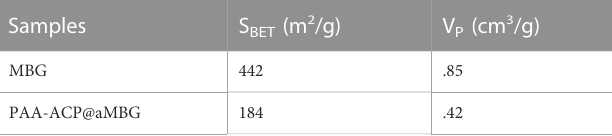
TABLE 1 Speci fi c surface areas and pore volumes of MBG and PAA-ACP@aMBG.